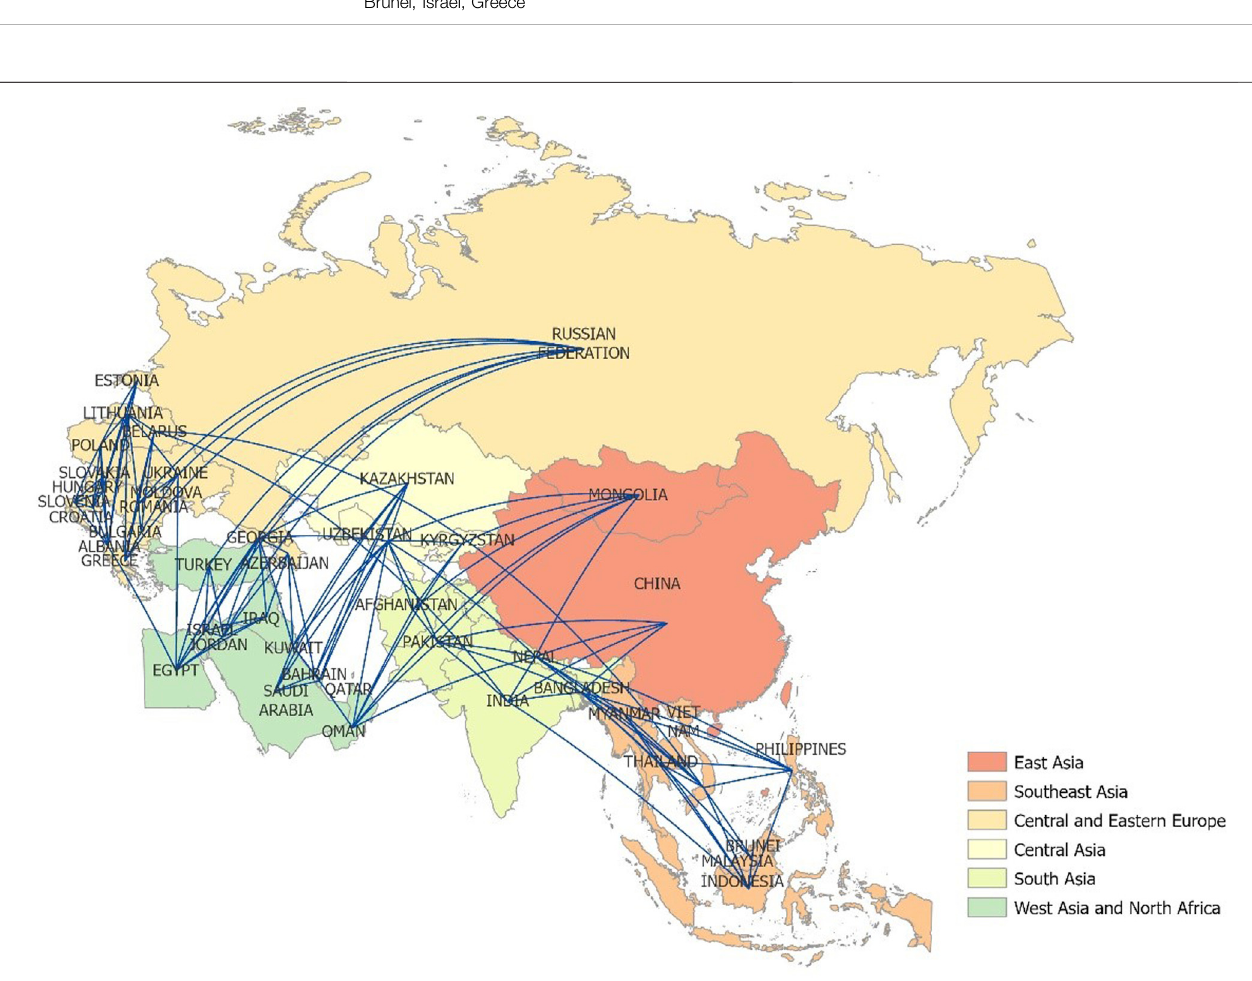
Frontiers in Environmental Science |